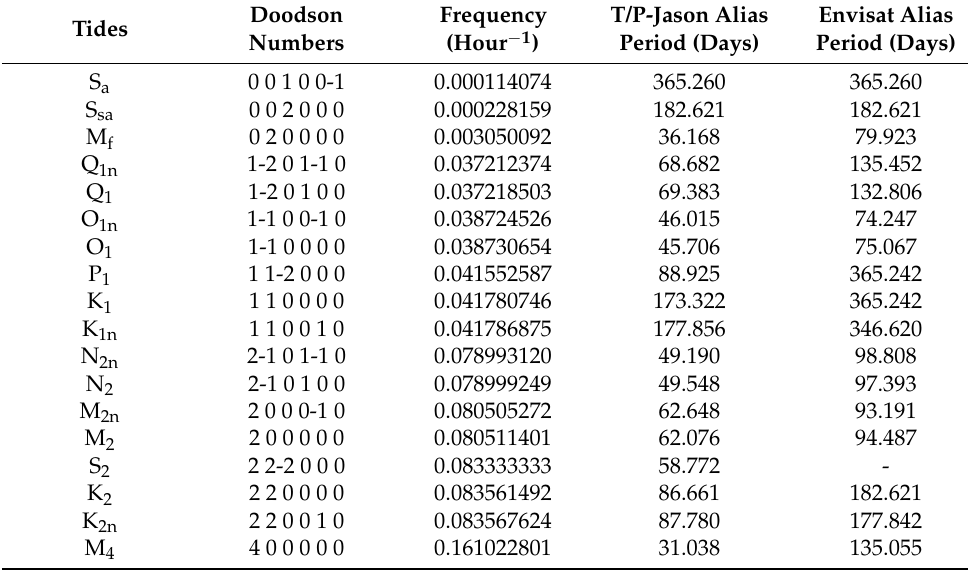
periods are calculated using s_alias function in S_TIDE toolbox